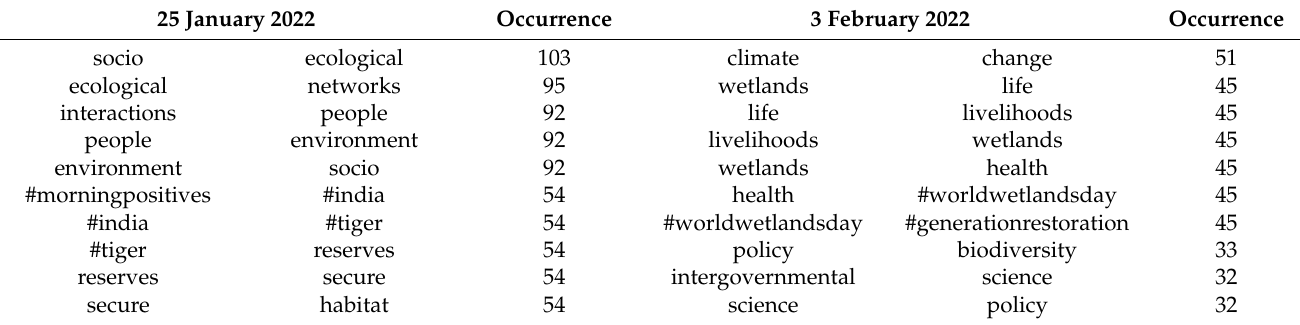
Table 6. Most frequent word-pairs in the analysed tweets.